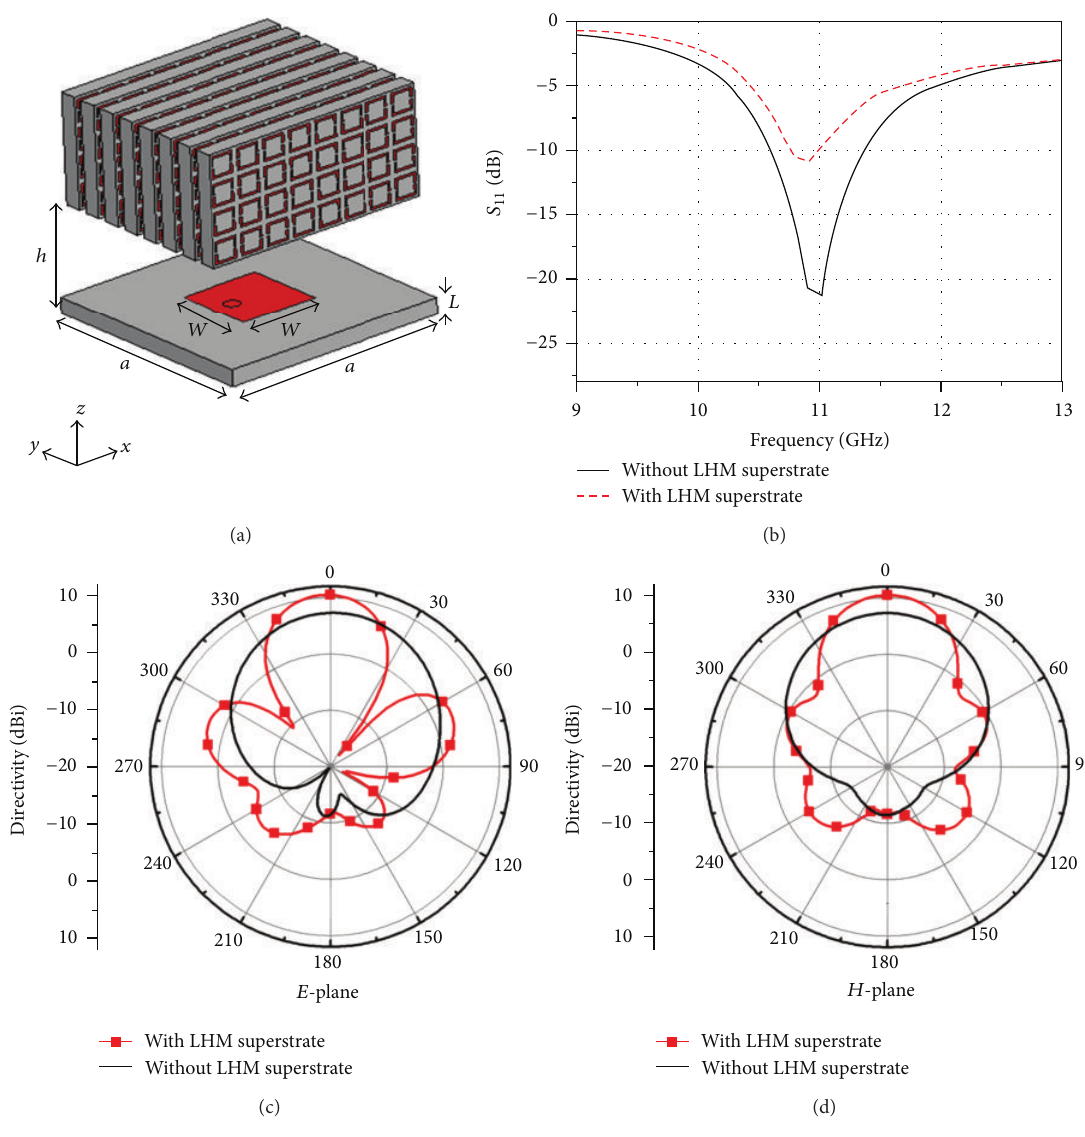
Figure 11: (a) Patch antenna with LHM superstrate, (b) 𝑆 11 characteristics, (c) comparison of directivity 𝐸 -plane patterns ( 𝑥𝑧 plane) with and without the LHM superstrate, (d) comparison of directivity 𝐻 -plane patterns ( 𝑦𝑧 plane) with and without the LHM